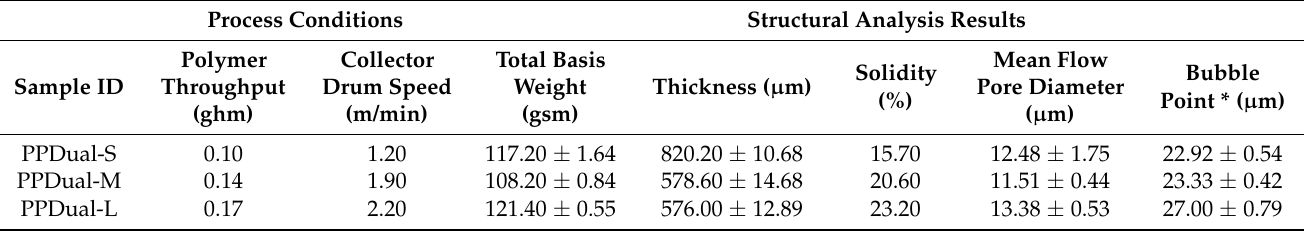
Structural Analysis